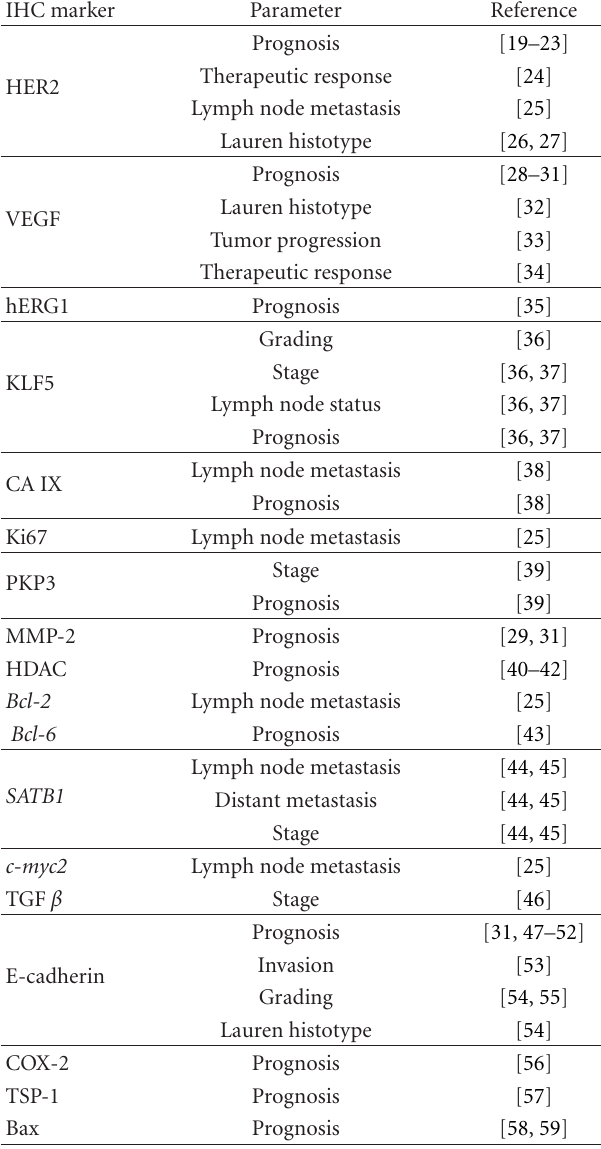
Table 1: Immunohistochemical markers in